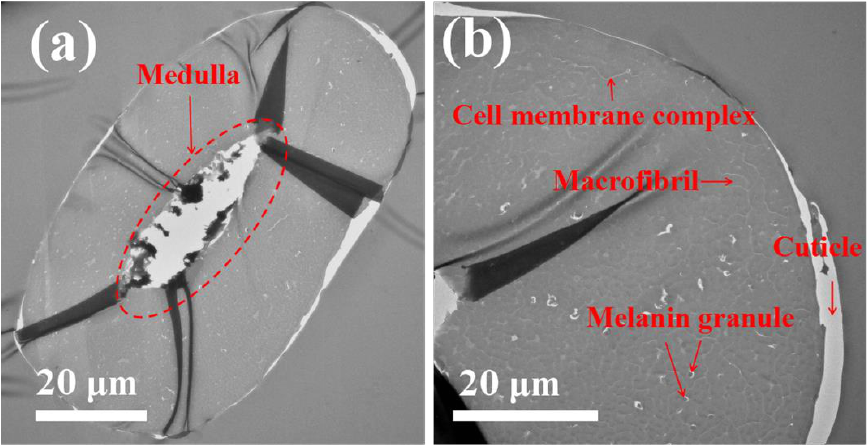
Figure 5. Transmission electron micrographs (TEM) of camel hair. ( a ) A cross section showing the centrally located medulla. ( b ) A highly magnified image showing its arrangement in an irregular form with the cuticle, matrix, macrofibril, and melanin granule.